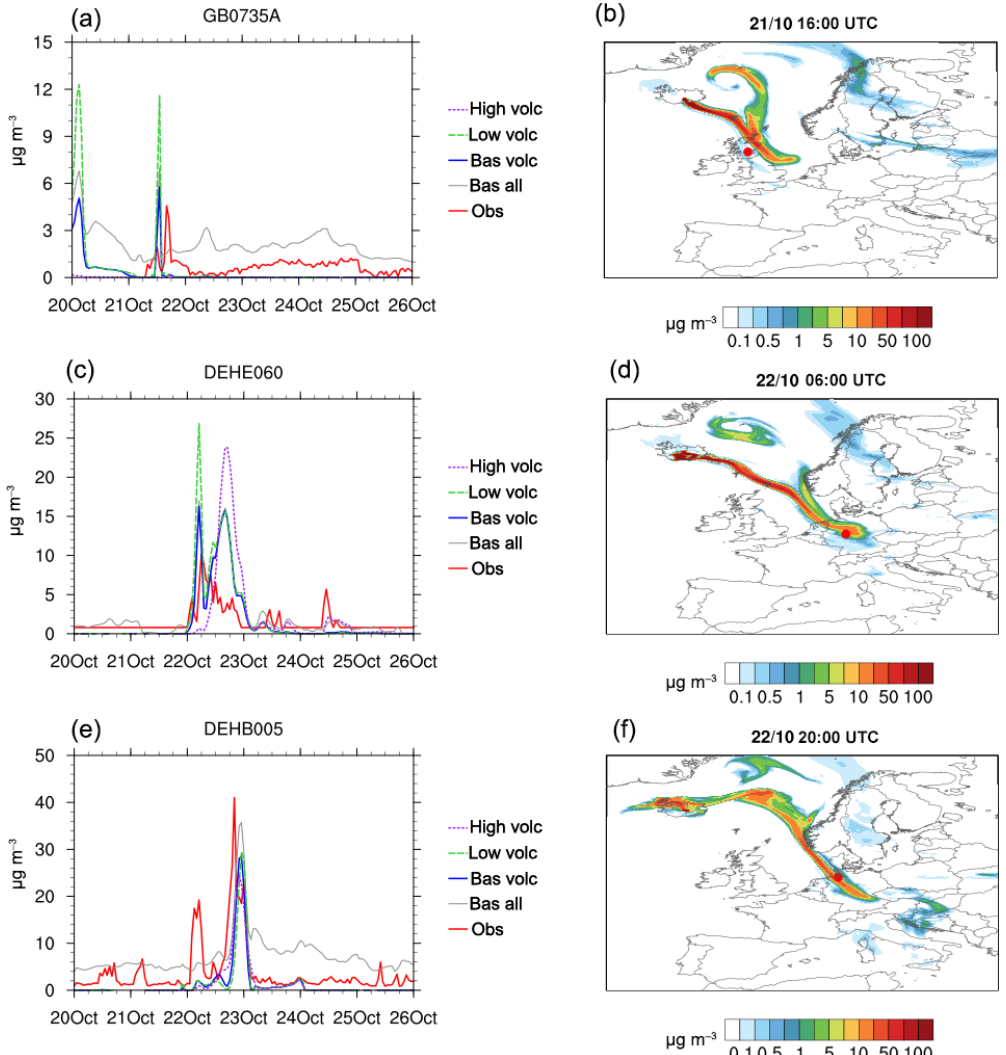
Figure 5. The same as Fig. 4, but from 20 to 26 October 2014 for three different stations GB0735A Grangemouth in Scotland, DEHE060 Kellerwald and DEHB005 Bremerhaven in Germany, all SO 2